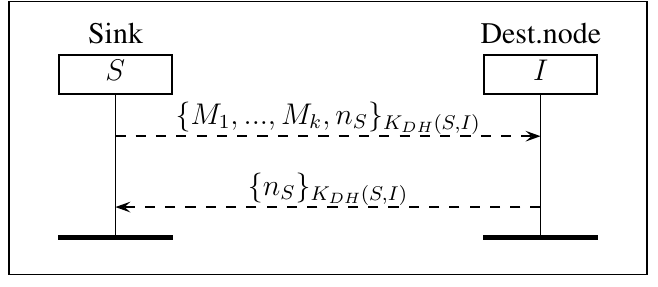
Figure 2. Key revocation protocol (KR): revocation of k malicious neighbor nodes of node I